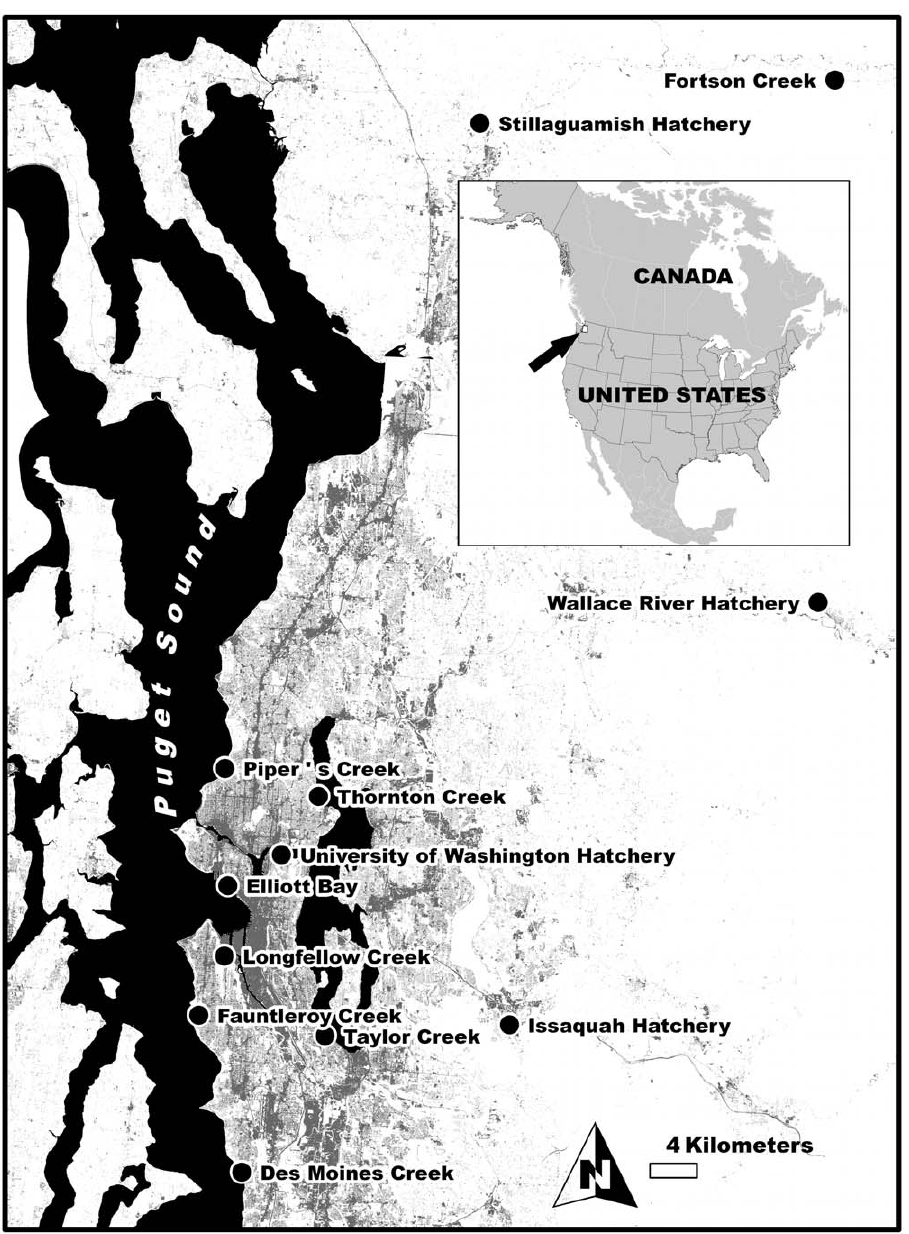
Figure 1. Stream survey and sample collection locations. The map indicates the greater Seattle metropolitan area, with gray shading representing the relative intensity of urbanization. Shown are the urban and non-urban creeks surveyed for coho spawner mortality, regional hatcheries, and the location of seawater-phase adult coho collections along the Seattle waterfront (Elliott Bay).